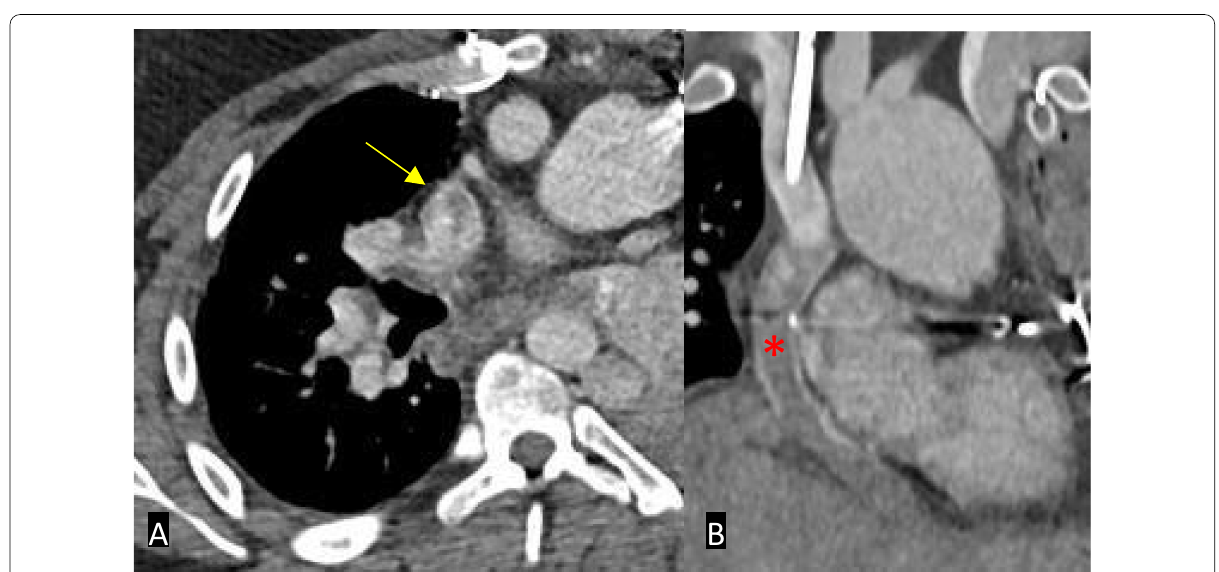
ECG, electrocardiogram; RVOT, right ventricular outflow